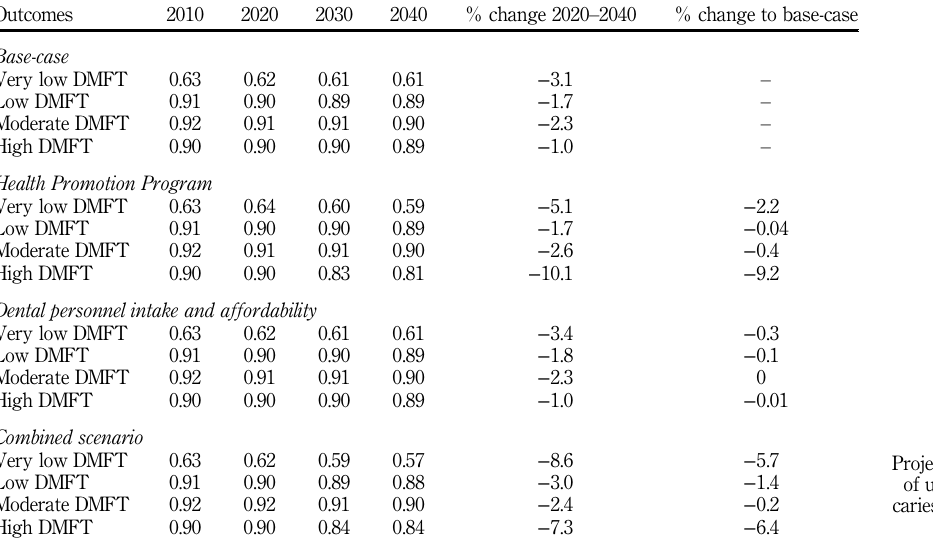
Table II. Projected